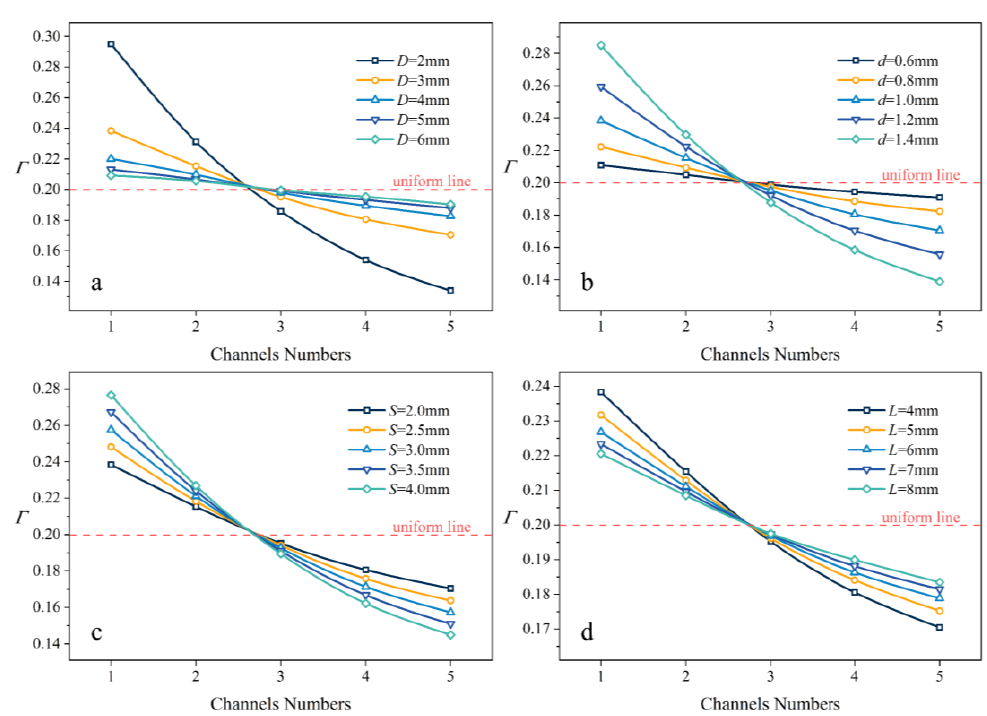
Figure 5. Influence of structural parameters on flow ratio ( Γ ). ( a ): The effect of changing D on Γ ; ( b ): The effect of changing d on Γ ; ( c ): The effect of changing S on Γ ; ( d ): The effect of changing L on Γ .